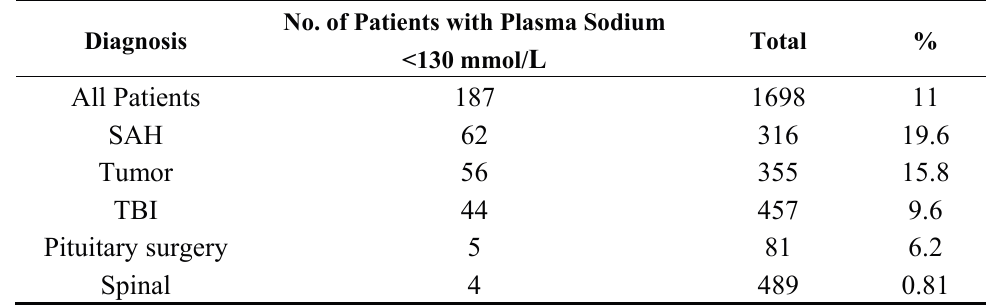
Table 1. Incidence of significant hyponatremia (plasma sodium <130 mmol/L) in patients admitted to the neurosurgical unit in Beaumont Hospital between January 2002–September 2003 (adapted from [7] with permission).